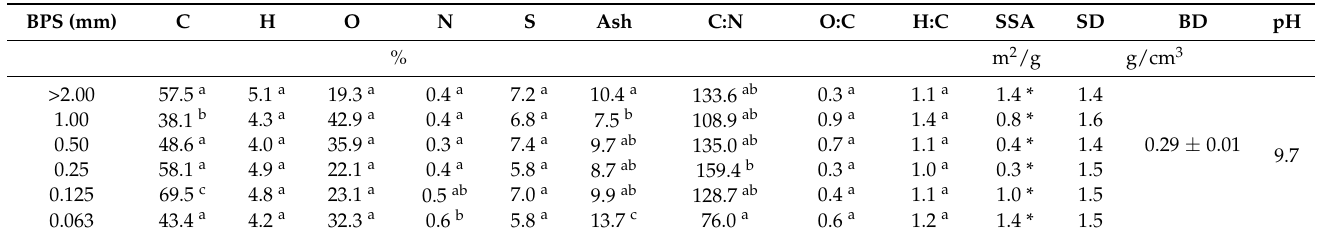
Table 2. Elemental analysis, specific surface area (SSA), and skeletal density (SD) of the biochar after sieving and granulo- metric classification with biochar particle size (BPS) distribution ranging 3.5 to 0.063 mm. BPS